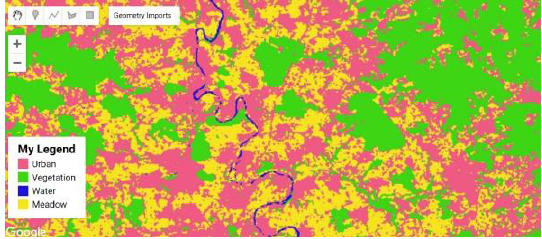
Figure 13: Zoom to Figure 12 (the Neckar river can be seen in the centre of the image)